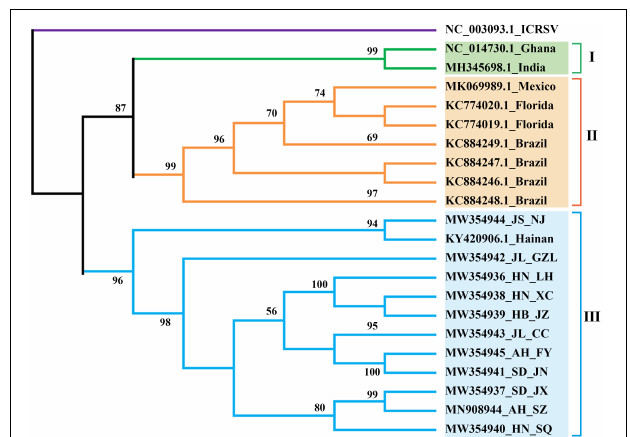
FIGURE 2 | ML-phylogenetic relationships among soybean mosaic virus (SMV) isolates from different countries. The phylogenic tree was constructed using MEGAX. Near-complete genome sequences of SMV isolates were obtained from NCBI (https://www.ncbi.nlm.nih.gov/). The colored bars (blue, orange, green, purple) indicate the different clades observed in the phylogenies.